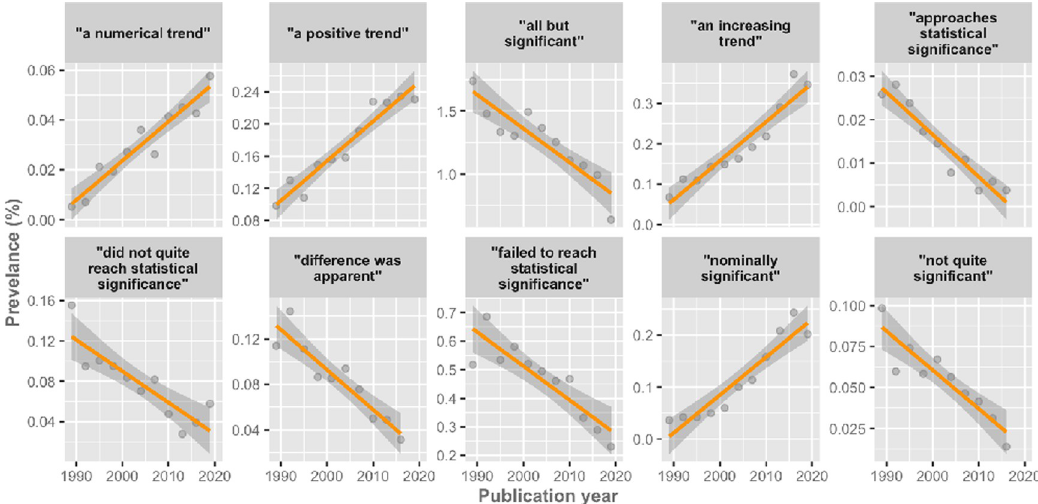
Fig 3. Temporal plots for phrases with “decisive” evidence (i.e., BFs > 100) for temporal change. Prevalence estimates are shown as dots, together with the linear regression model fit and corresponding uncertainty. The data can be found here: https:// github.com/wmotte/almost_significant/tree/main/Fig_and_Data. BF, Bayes factor.